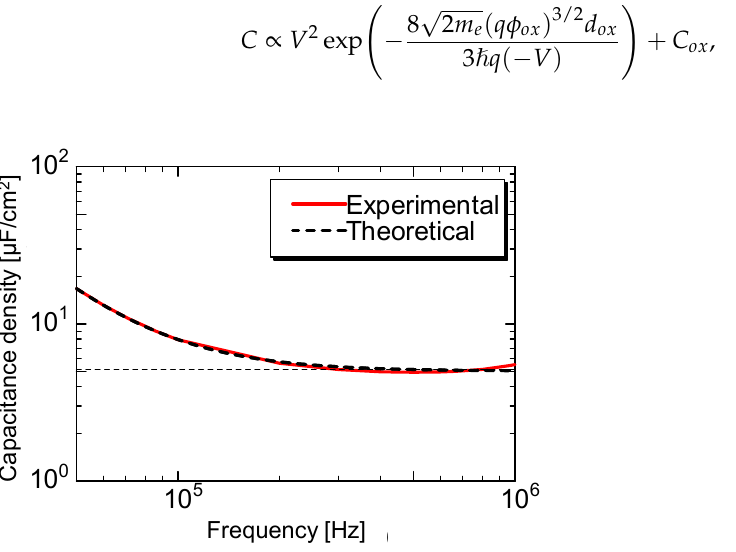
Figure 6. ( a ) Equivalent circuit depicting the interface impedance ( C i , R i ) in series with the oxide capacitance ( C ox , R ox ). ( b ) Total observed capacitance C and resistance R in terms of an equivalent series circuit.